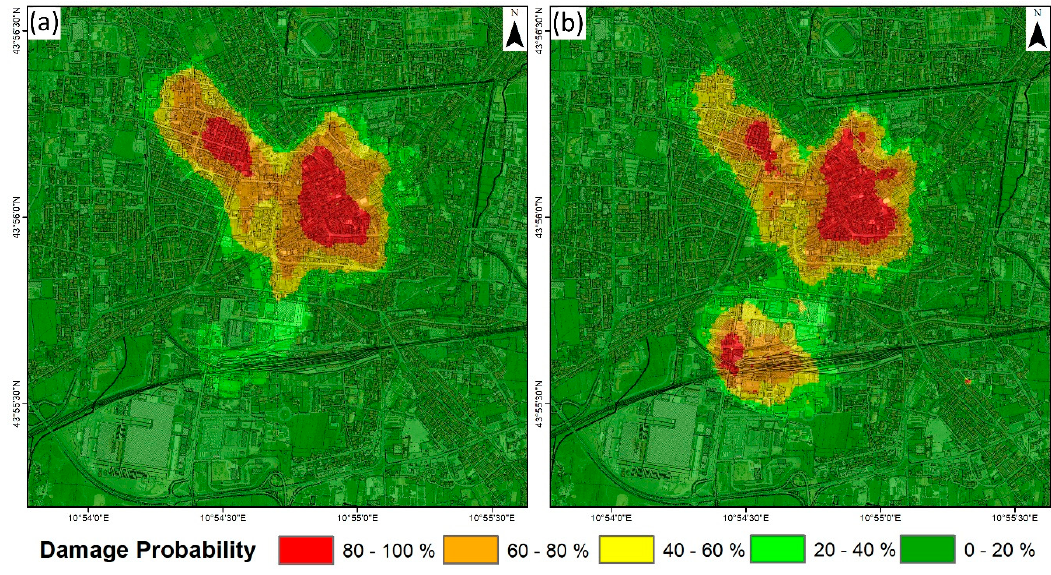
Figure 8. Damage probability spatial distribution calculated using the S-1 ( a ) and CSK ( b ) fragility Figure 8. curves.